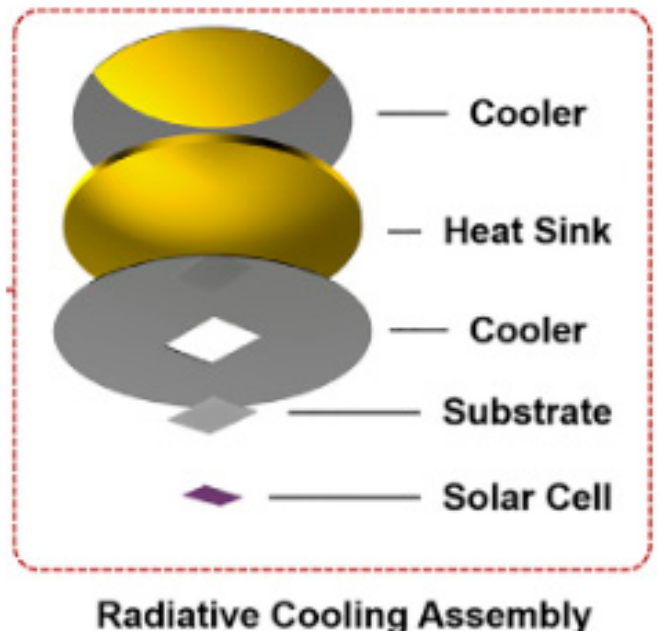
Figure 40. Traditional cooling methods are applied with lightweight DPRC coatings [181]